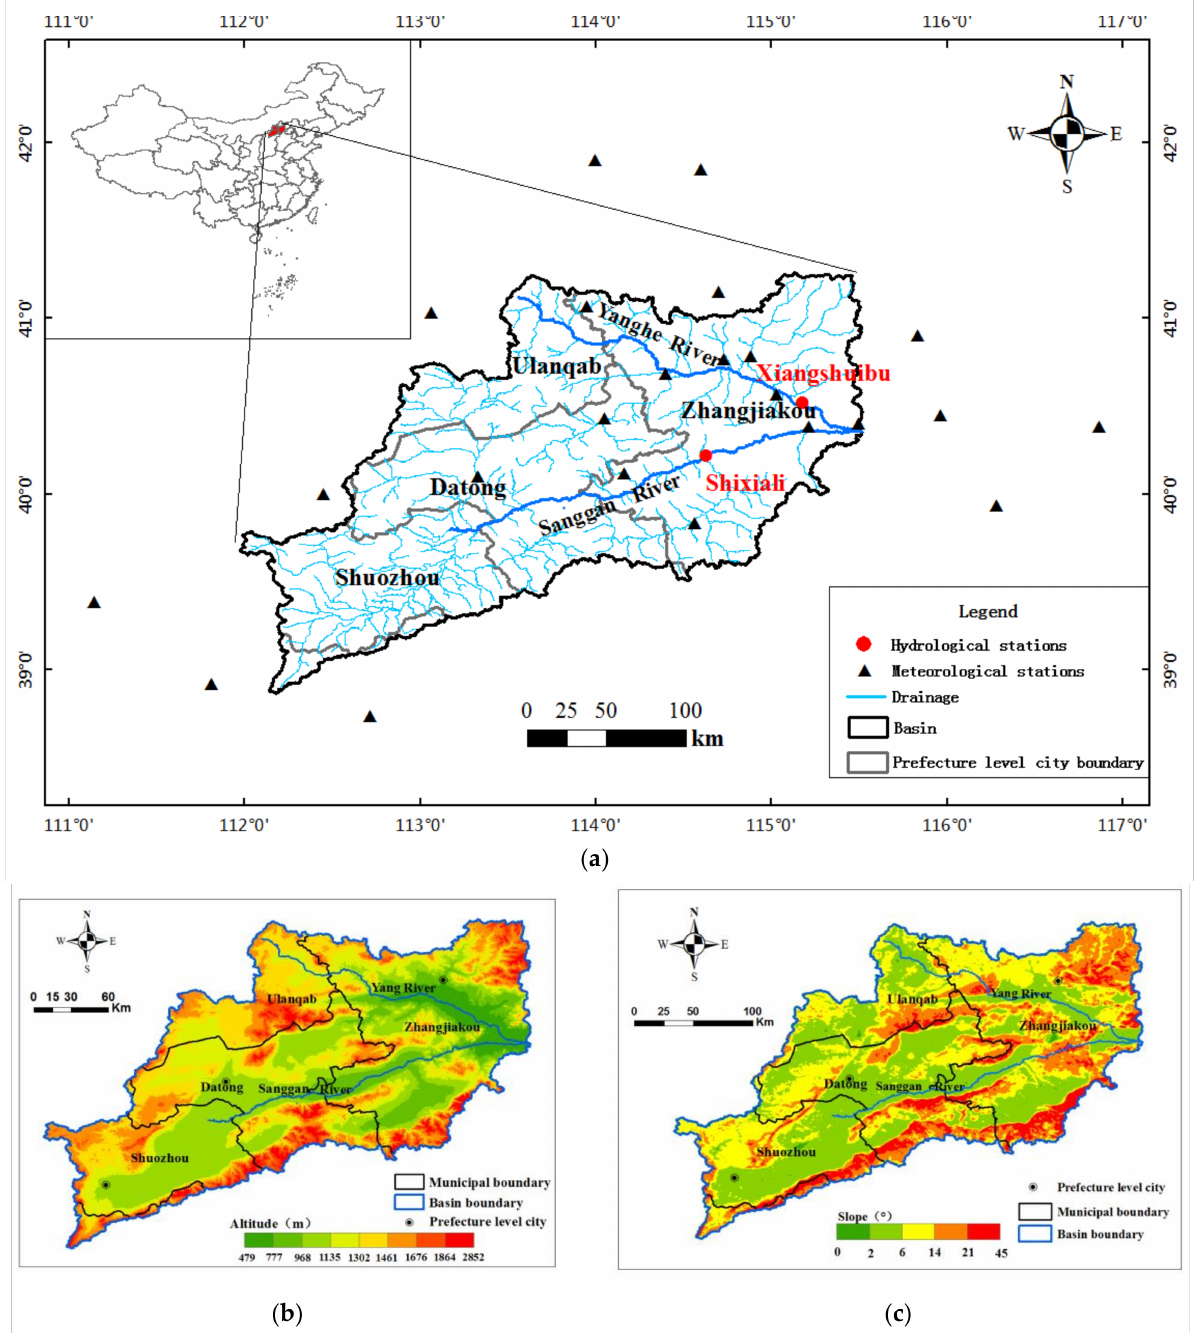
Figure 1. Location of the UYRB showing meteorological and hydrological stations ( a ) and background topography ( b , c